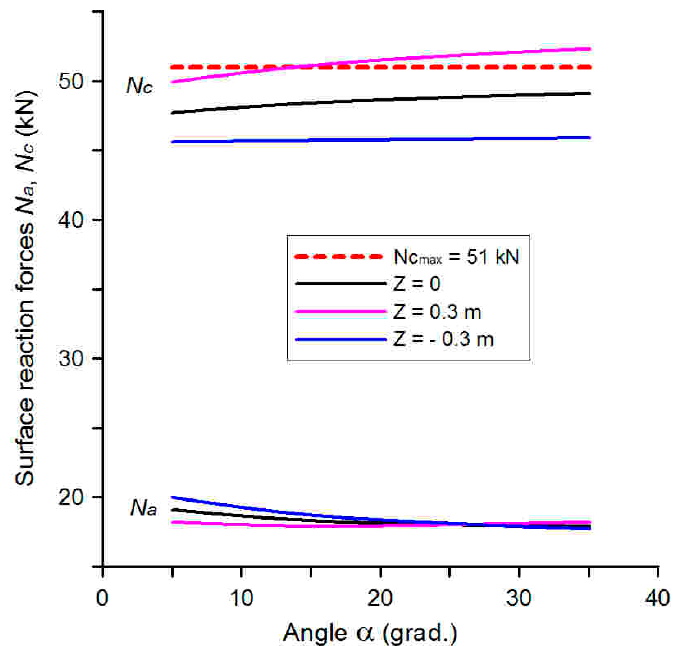
α of installation of the central link of